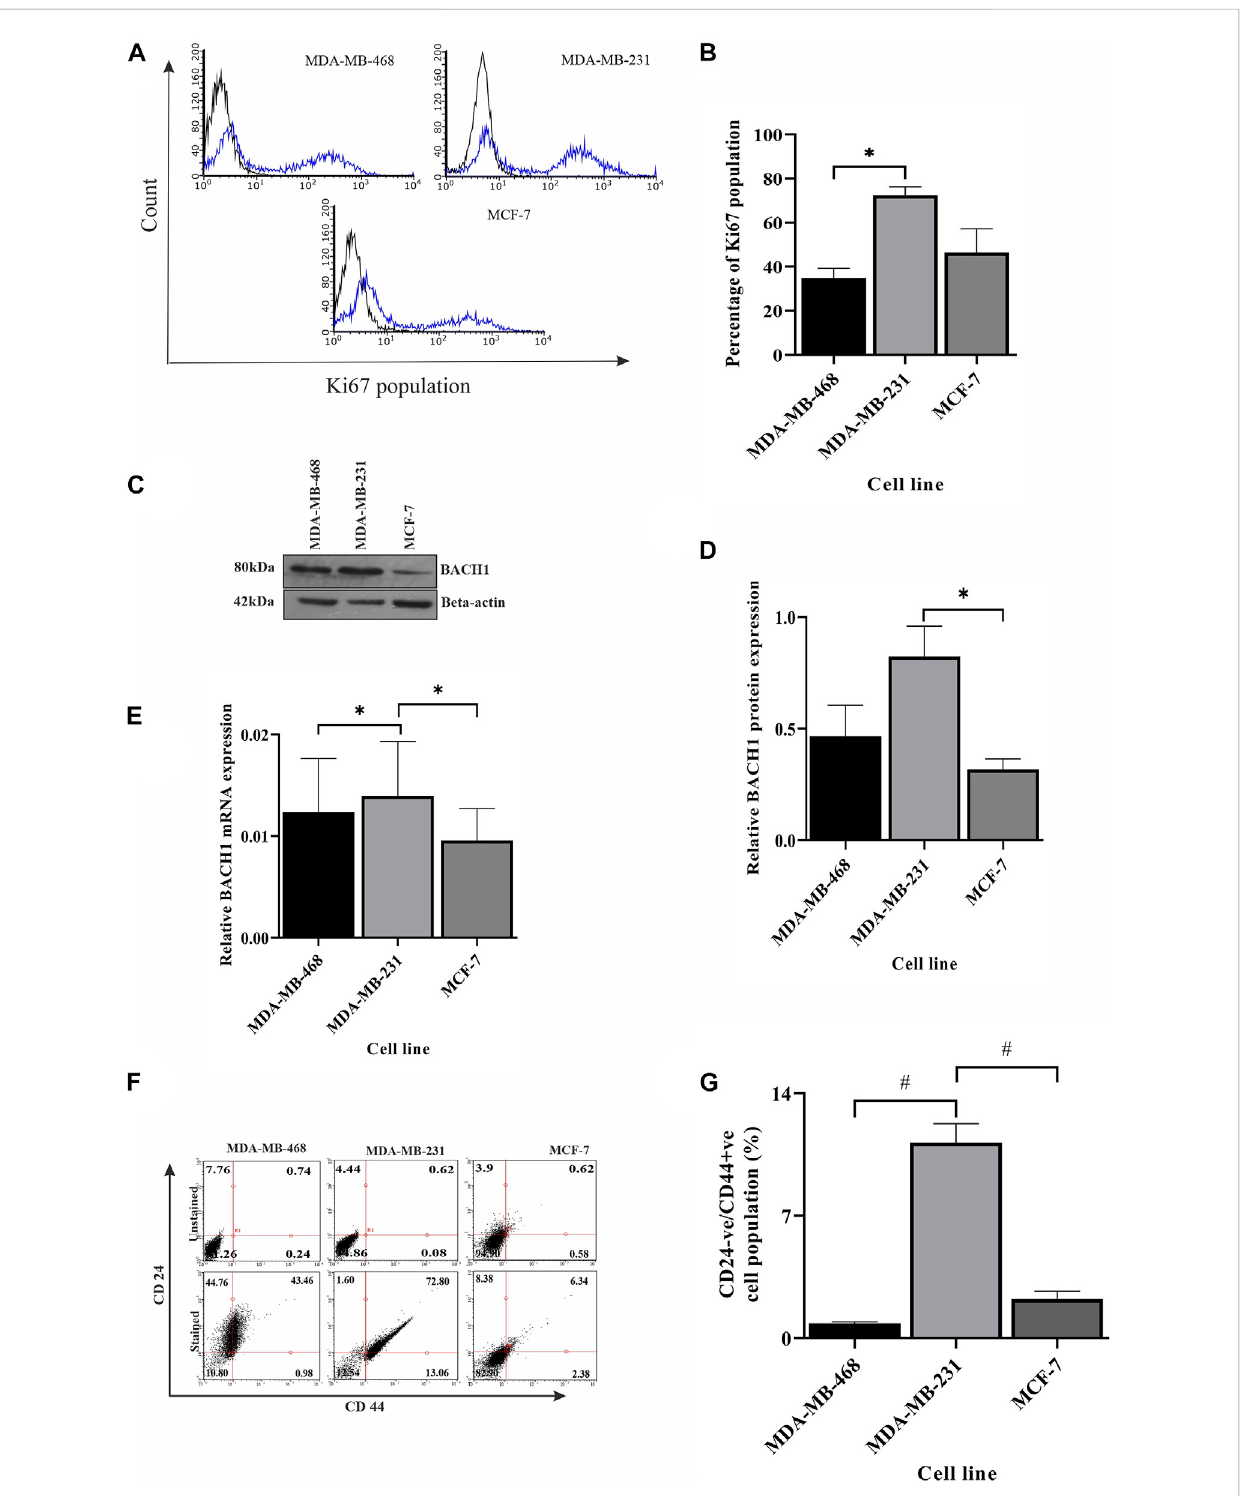
FIGURE 5 Severity is highly dependent on repair pathways. (A) Ki67 is overexpressed in MDA-MB-231 cells compared to other breast cancer subtypes. The proliferation of different breast cancer lines, TNBC subtypes MDA-MB-468 and MDA-MB-231, and luminal type cell line MCF-7 were monitored by measuring the Ki67 marker using immunophenotyping assay and represented by histogram plots (the black line indicates the unstained population, and the blue line indicates the Ki67 stained population). (B) Quanti fi cation of the Ki67 population in different cell types. The bar graph represents the percentages of cells having Ki67 expression, which was measured by gating the Ki67 population using Guava InCyte software. (C) The angiogenic/ metastatic factor in breast cancer BACH1 overexpresses in MDA-MB-231 cells. The protein expression of metastasis marker BACH1 was detected by western blot analysis of proteins extracted from the aforementioned cells using the corresponding antibody. β -Actin is given as the loading control. (D) Quanti fi